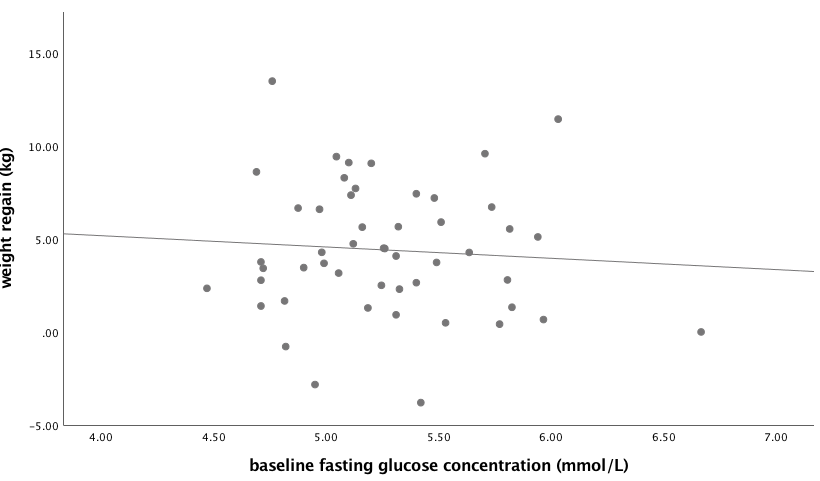
Figure 1. Association between baseline fasting glucose concentration and weight regain ( n = 50).